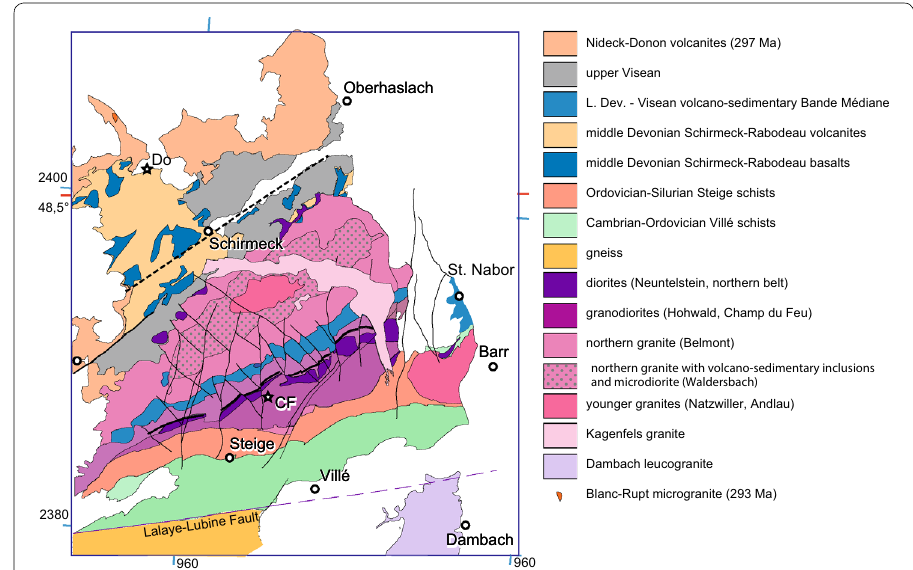
Fig. 4 Geological map of the Palaeozoic northern Vosges after von Eller et al. (1970) and Elsass and von Eller (2008). CF Champ du Feu, Do